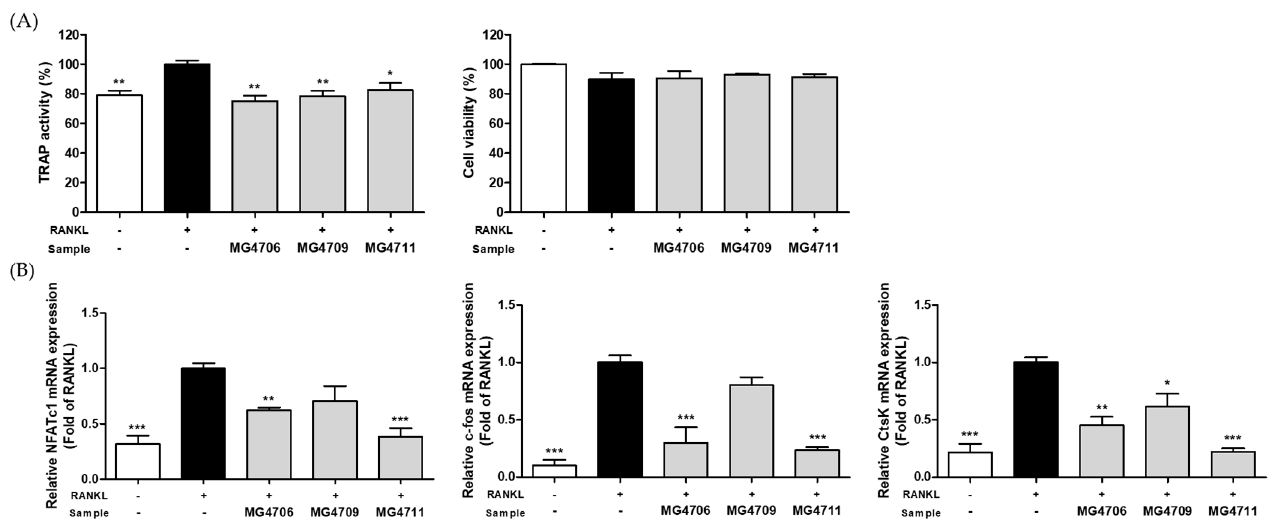
Figure 2. Effect of CFSP from LAB on ( A ) TRAP activity and cytotoxicity and ( B ) expression of osteoclastogenesis specific genes ( NFATc1 , c-fos , and CtsK ) in RANKL-induced RAW264.7 cells. Data are represented as mean ± SEM ( n = 3). Significance was analyzed by Dunnett’s test. * p < 0.05, ** p < 0.01, *** p < 0.001 versus only treated-RANKL group.